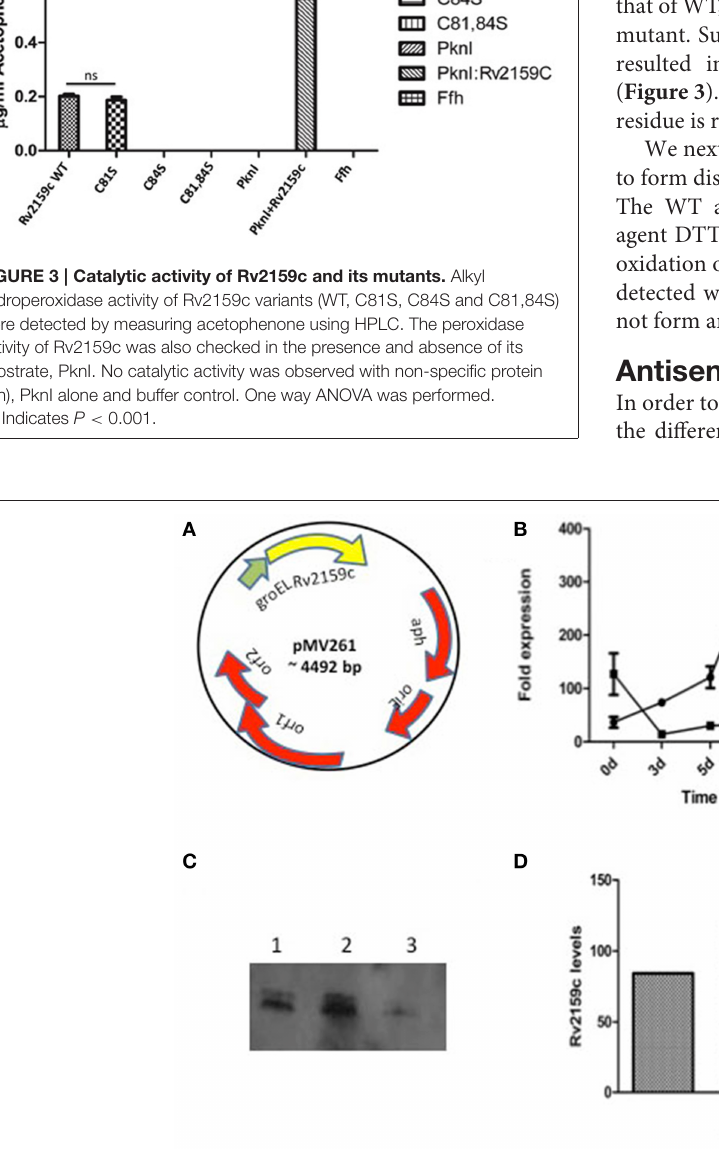
Frontiers in Microbiology |